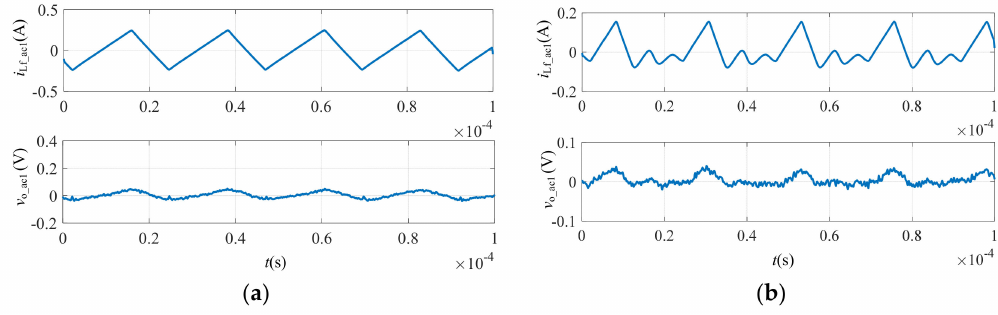
Figure 8. Experimental waveforms of Buck converter after de-noising: ( a ) CCM; ( b ) DCM.